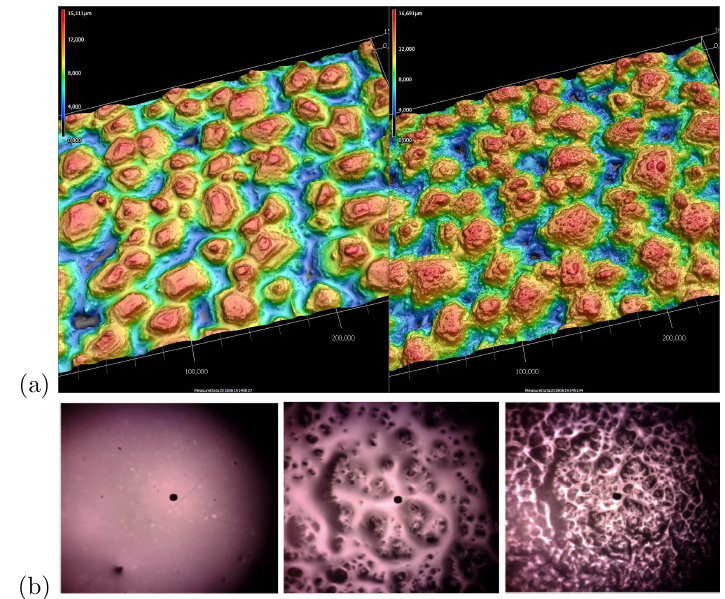
Figure 1: Water droplets – (a) Pictures taken using Keyence KV-X: on the left, the frosted glass is covered by a film of water, and on the right the frosted glass is dry. (b) Pictures taken using Filmetrics during evaporation. The surface started dewetting in the middle picture. On the right, we can see a complex network of water threads. The side dimension of the picture is about 1 mm.